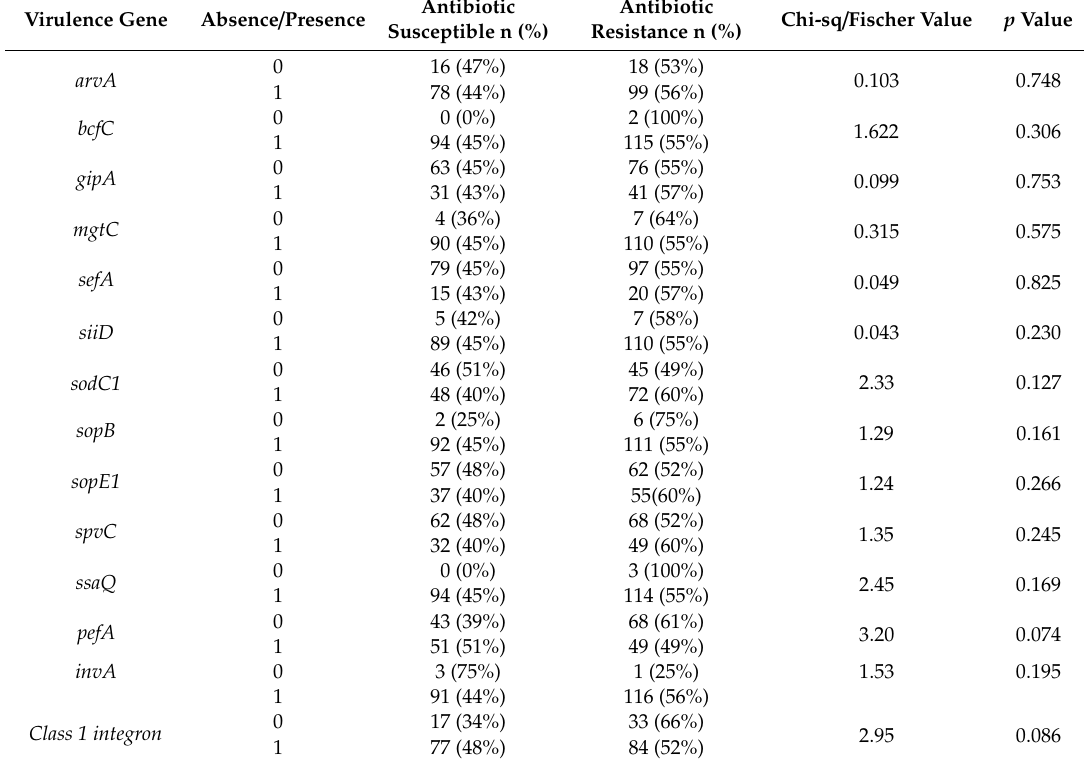
Association between any antibiotic resistance and virulence genes in Salmonella isolates ( n =